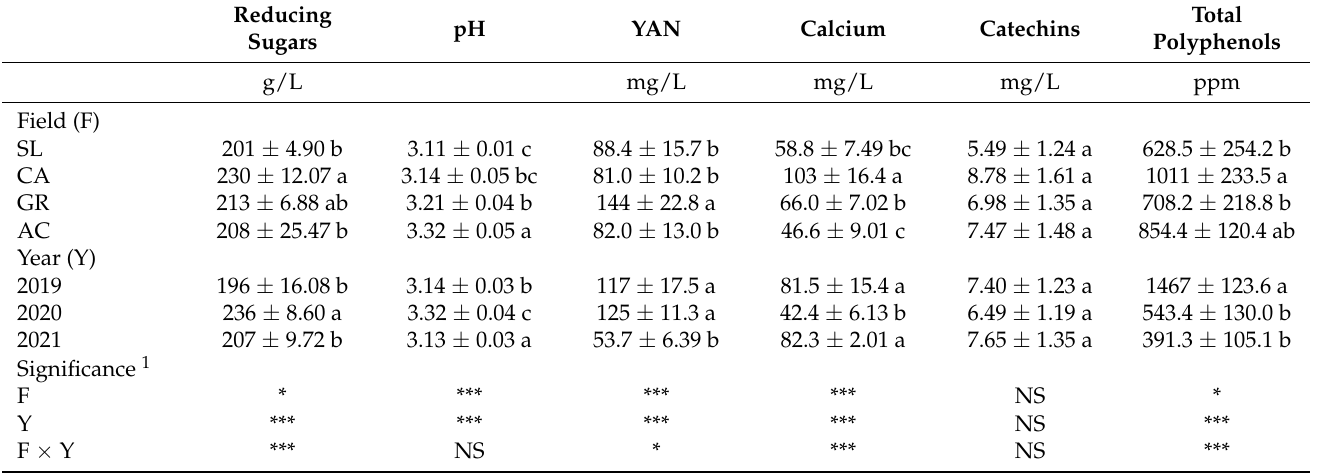
Table 4. Effects of field (F), year (Y) and their interaction (F × Y) on reducing sugars, pH, YAN, calcium, catechins, total polyphenols of V. vinifera subsp. vinifera “Falanghina” vines at the four study sites: SL-Santa Lucia, CA-Calvese, GR-Grottole, and AC-Acquafredde. Mean values and standard errors are shown. Different letters within each column indicate significant differences according to Duncan’s multiple comparison tests ( p ≤